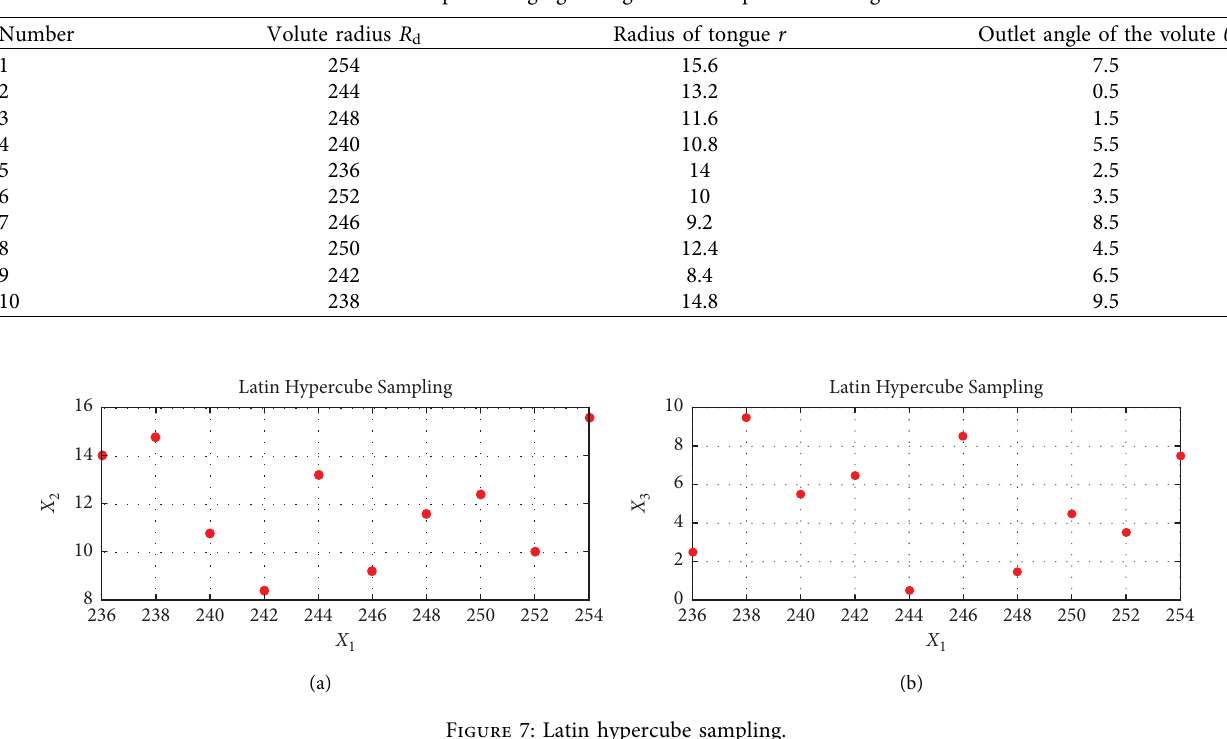
Table 3: Self-adaption Kriging surrogate model optimization algorithm.